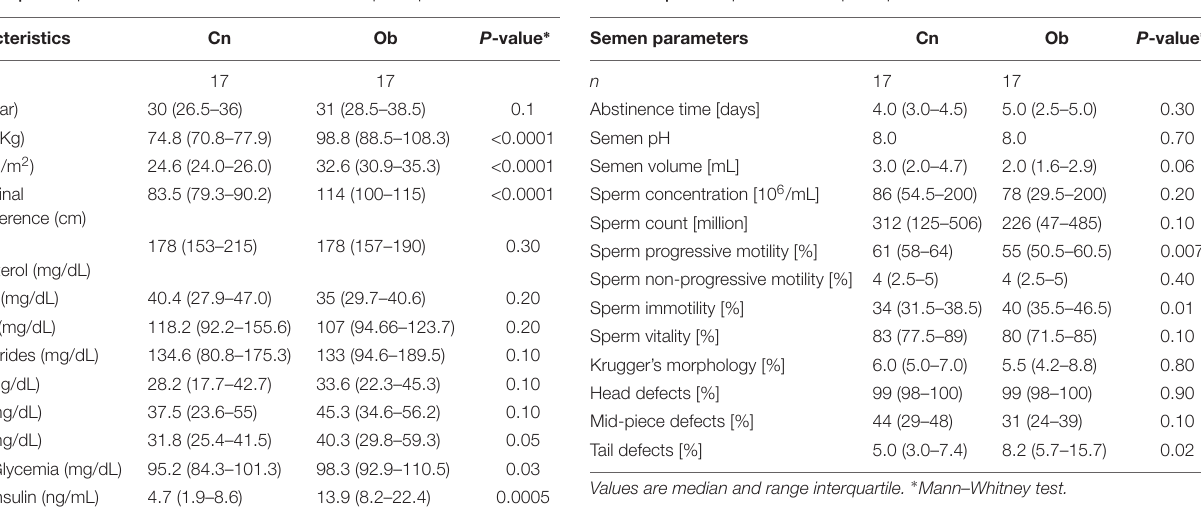
TABLE 4 | Semen parameters of participants.